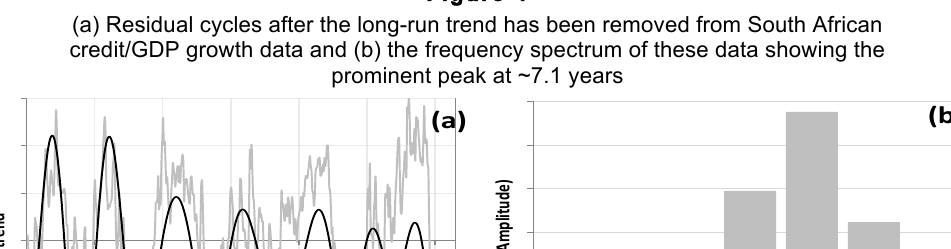
components. The frequency spectrum in Figure 4b indicates that the main component has a frequency of approximately 7 years. This is the duration of South Africa's business cycle, found previously (Botha, 2004).